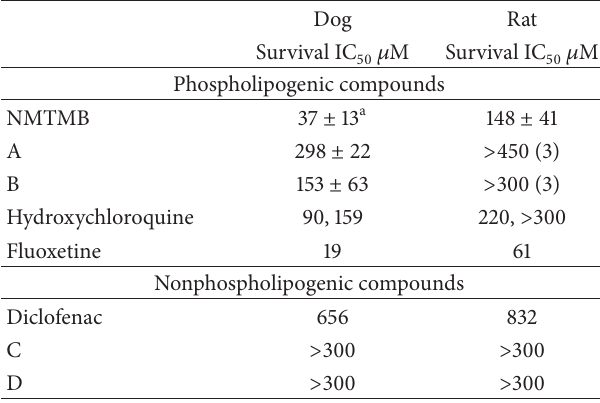
(half maximal inhibitory concentration) Table 1: Cell survival IC 50 values of dog and rat hepatocytes treated with phospholipogenic or non-phospholipogeniccompounds.Cellswerefixedwithformalde- hyde/ Hoescht, and survival was quantified using the Cellomics Arrayscan instrument (see Materials and Methods). Isolates were obtained on different days. The data are represented as individual experiments only ( 𝑁 = 1 or 2) or as an average of 3 individual (separate isolates, 𝑁 = 3) experiments ±